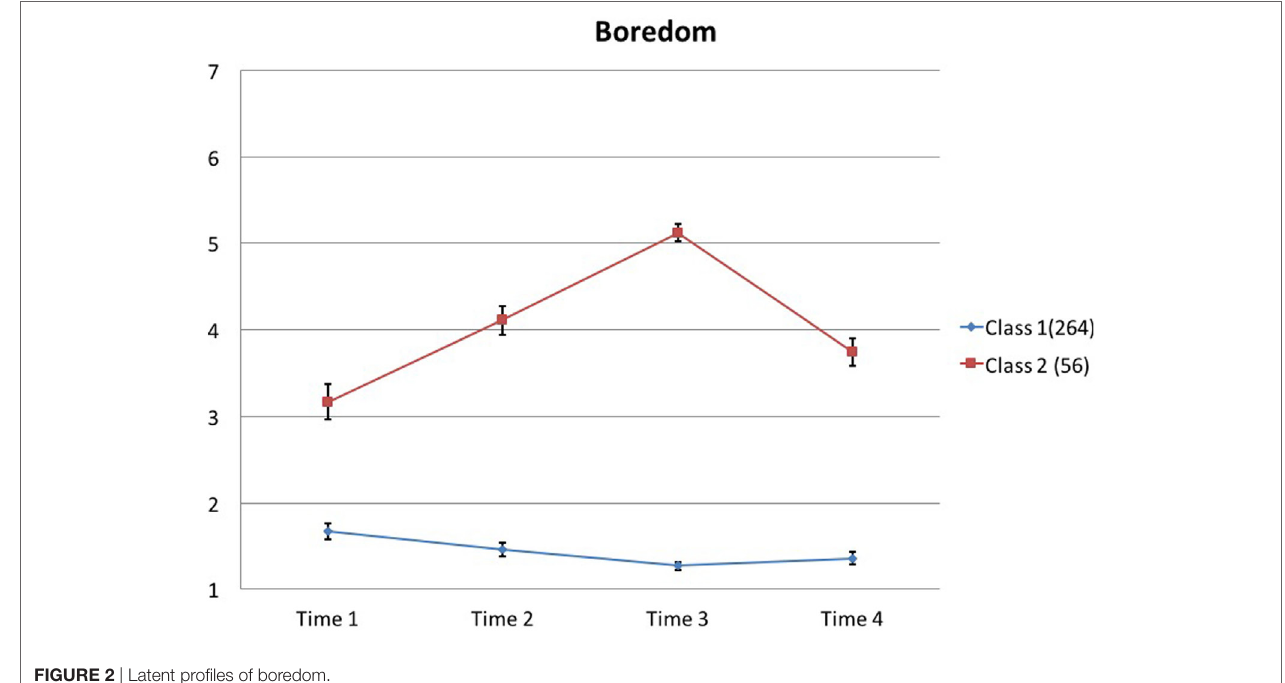
FigUre 2 | Latent profiles of boredom.